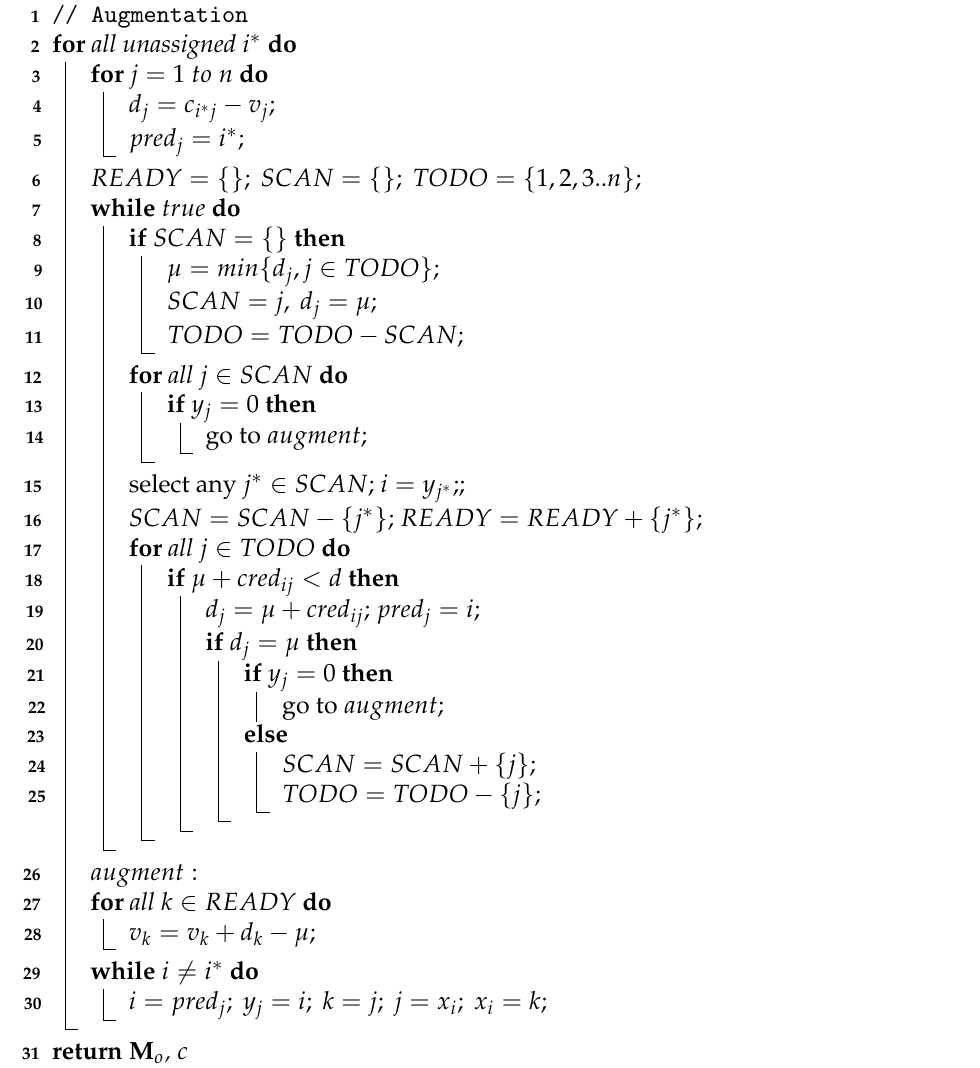
Algorithm 3: Augmentation Process of